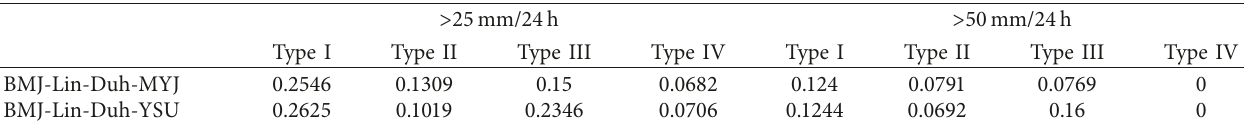
Figure 8: TSs for different types of heavy rainfall events in northern Vietnam for daily accumulation thresholds over (a) 25mm and 50mm (b) at 24h forecast ranges and over 25mm (c) and 50mm (d) at 48h forecast ranges. The right vertical axis is from 0 to 0.4. Table 7: TSs for different types of main heavy rainfall, at the 24 h forecast range for thresholds > 25mm/24 h and > 50mm/24 h, for the period